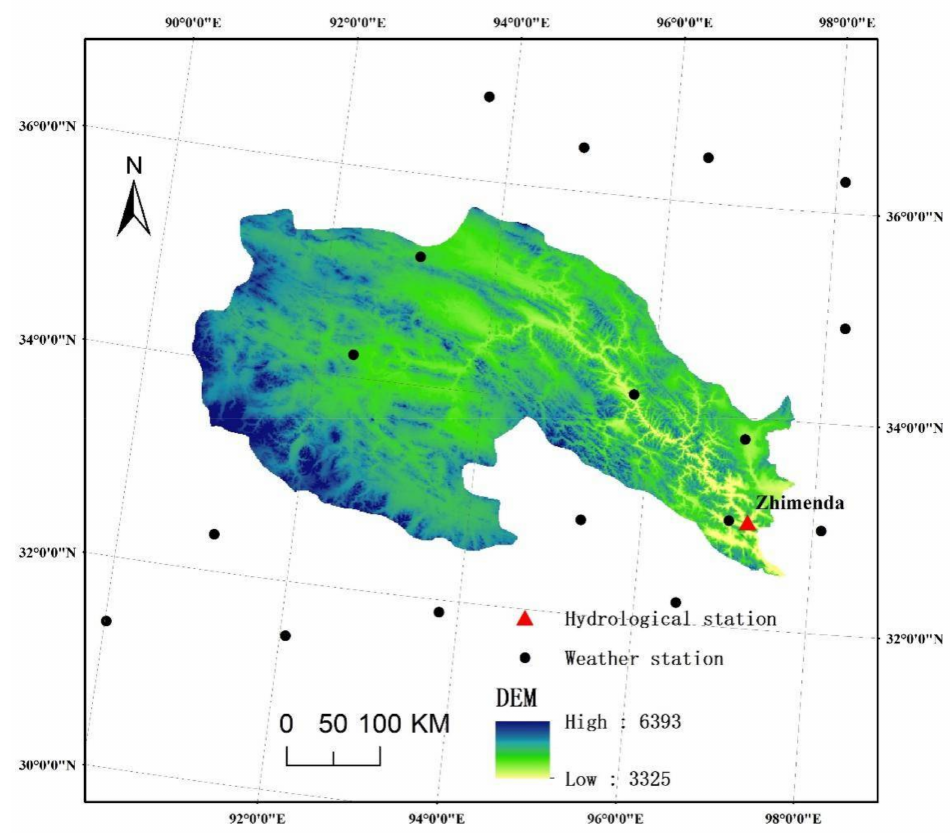
Figure 1. The location of hydrological and meteorological stations in and around the source region of the Yangtze River